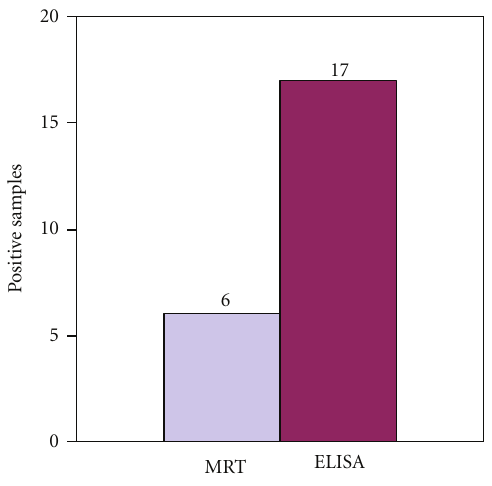
Figure 1: Graphical comparison of MRT with i-ELISA for detection of antibrucella antibodies in Milk Samples.